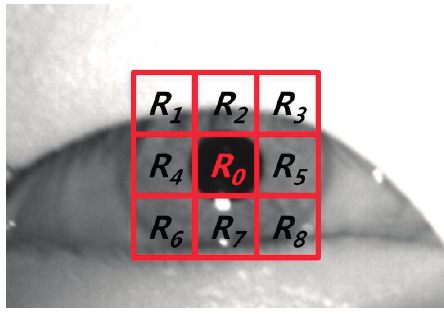
Figure 4. Example of sub-block-based template matching algorithm.